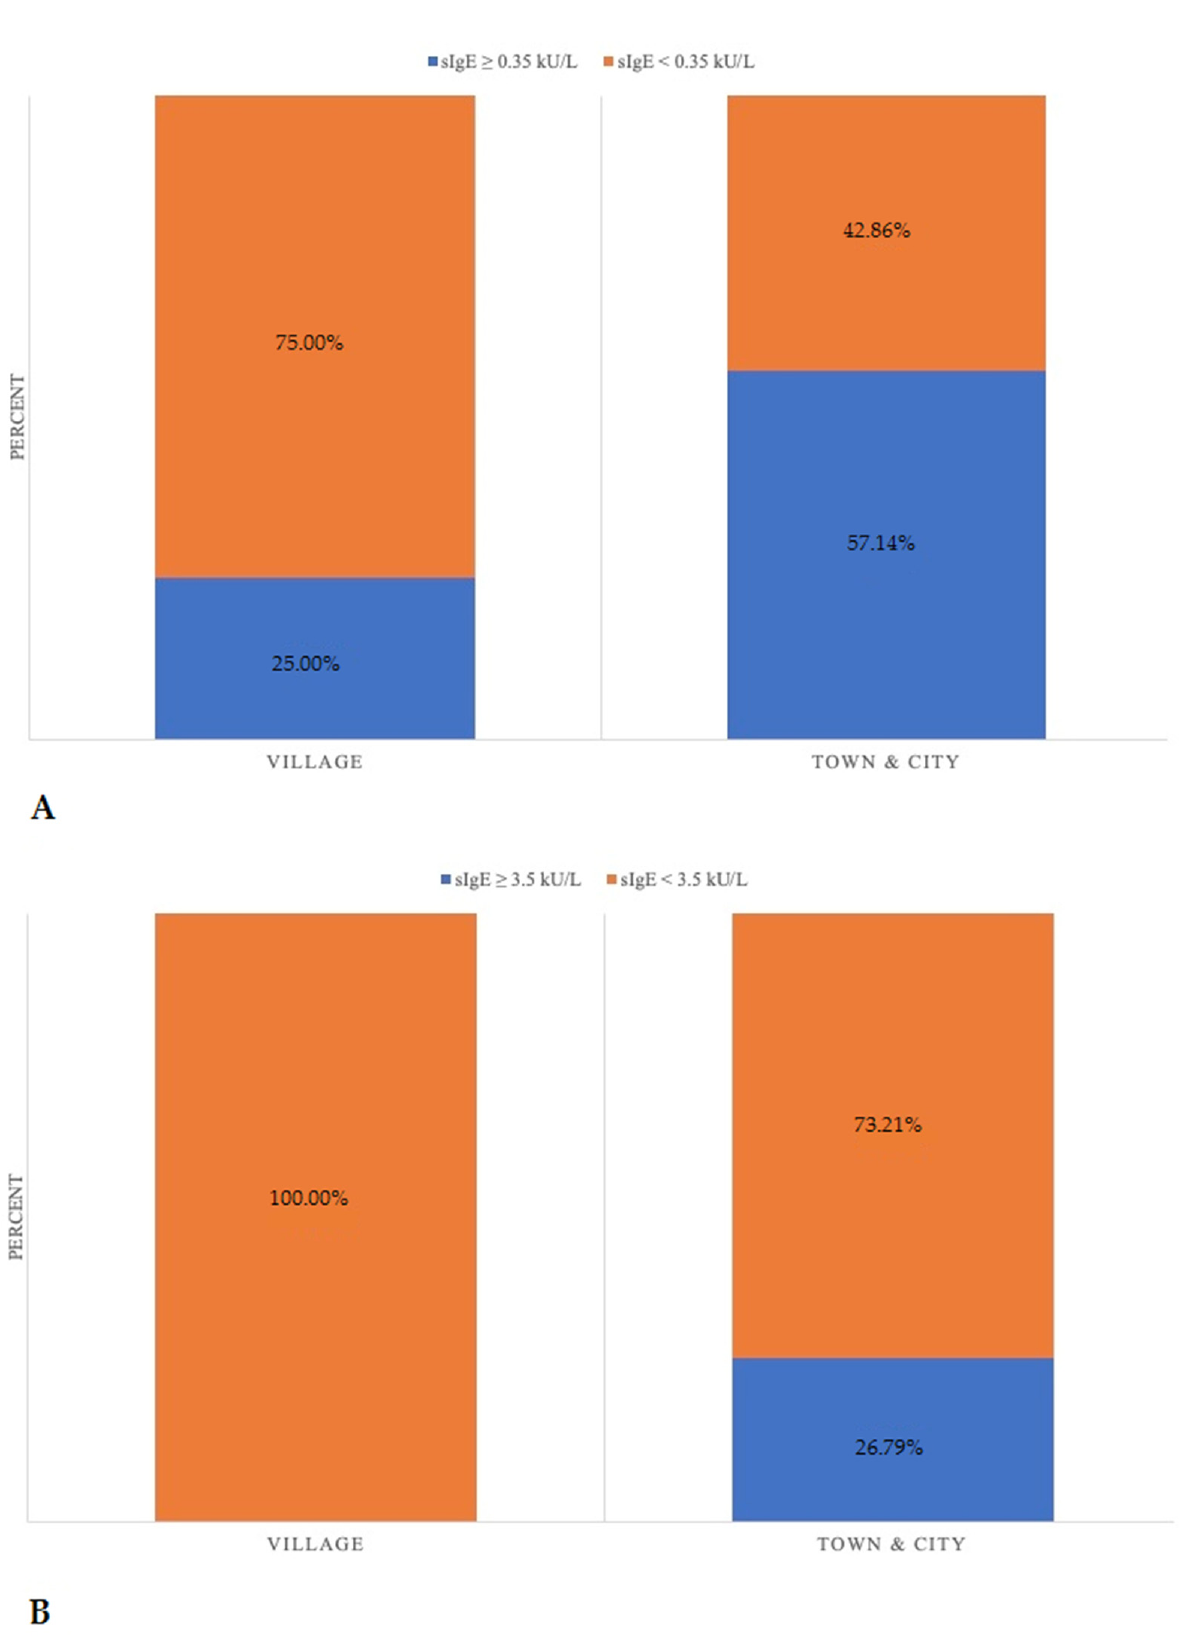
Figure 2. ( A ). sIgE level depending on the living place ( p = 0.047). ( B ). Prevalence of allergen-specific IgE concentration ≥ 3.5 kU/L depending on the living place (village vs. town and city; p = 0.047).